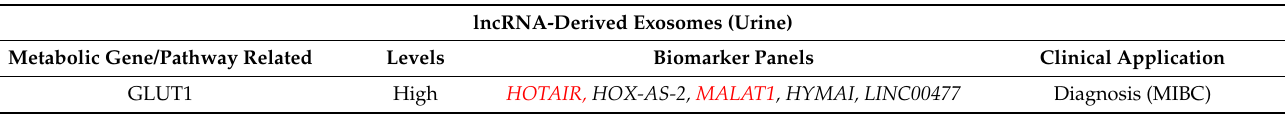
Table 6. lncRNA markers found in BC-derived exosomes from urine of patient